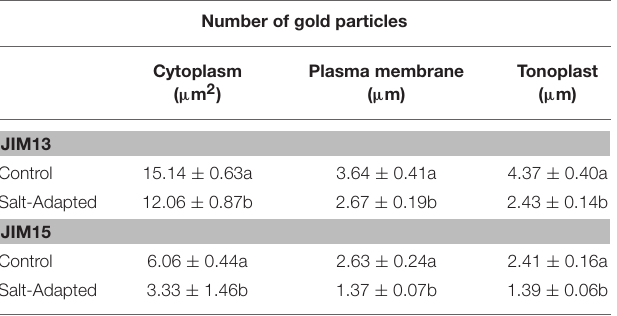
TABLE 2 | Quantitative analyses of immunogold labeling distribution of arabinogalactan proteins (JIM13 and